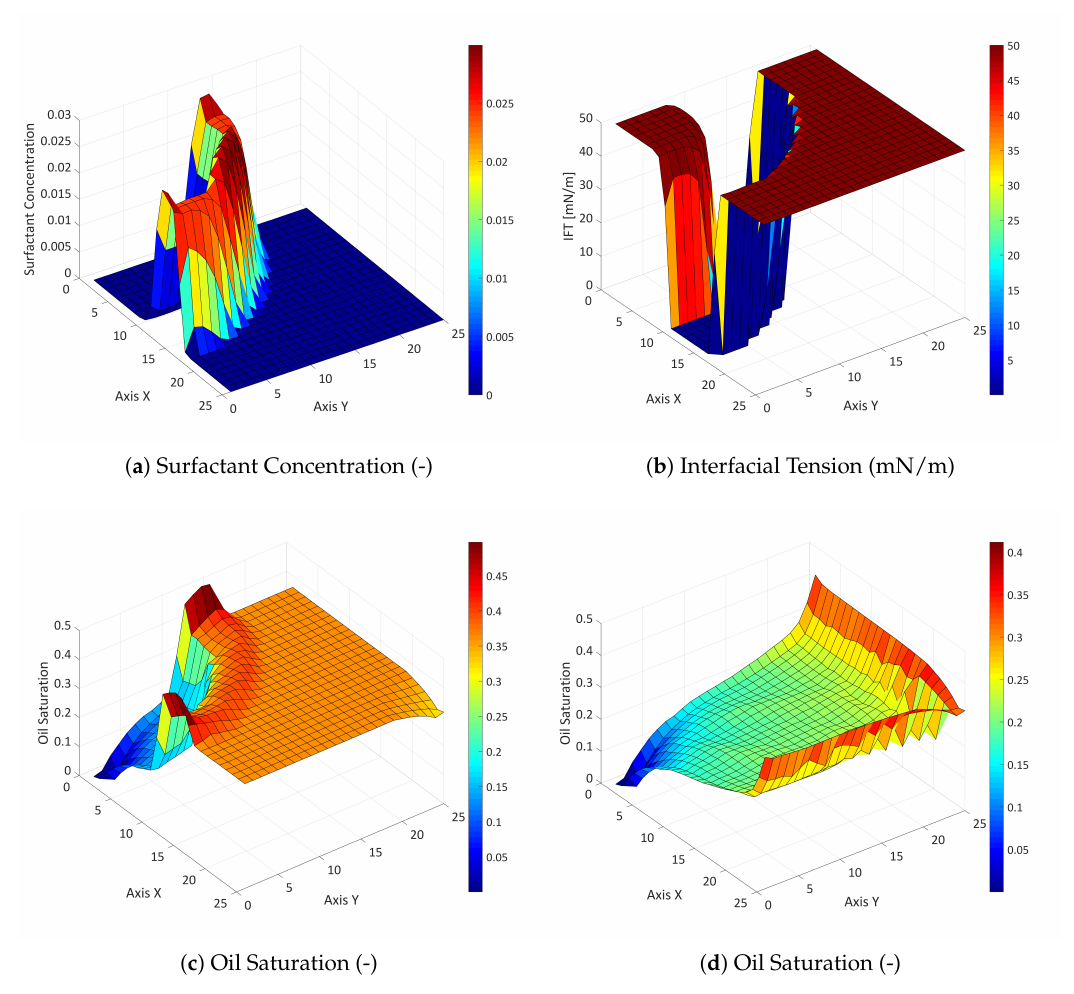
Figure 8. Chemical ( a ) and IFT [mN/m] profiles ( b ) after 1000 days of simulation. Oil saturation profiles at 1000 days ( c ) and at the end of the EOR process ( d ) for a Type II( − ) emulsion with k c =